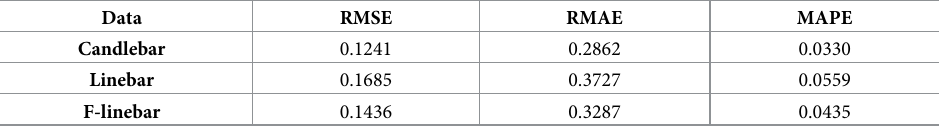
Table 3. Comparison of out-of-sample results for fusion chart images using the SC-CNN model.